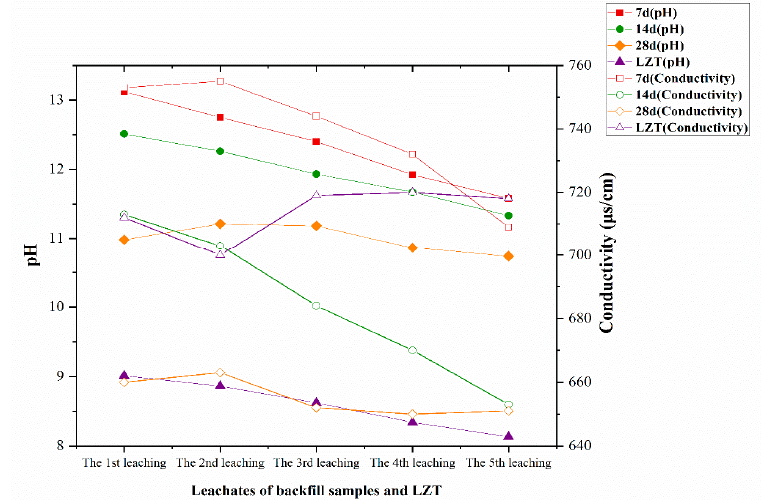
Figure 10. Changes in pH and conductivity in dynamic leaching.